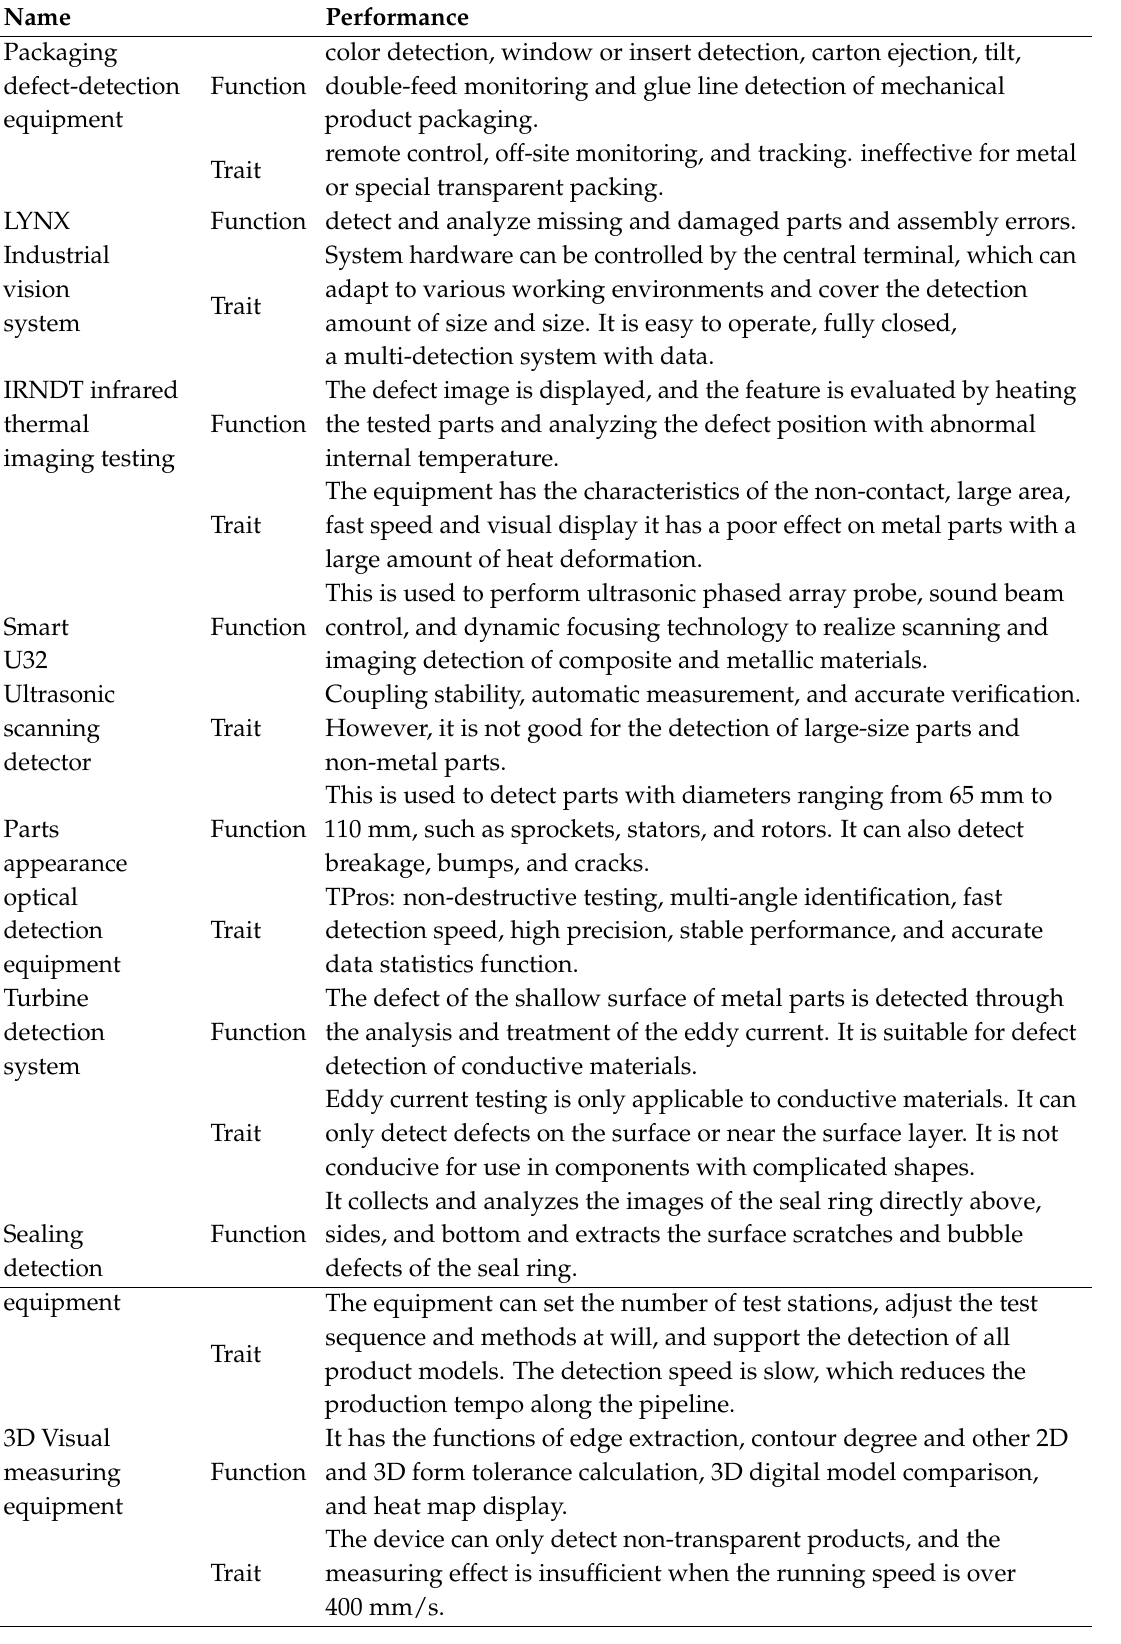
Table 5. Existing defect-detection